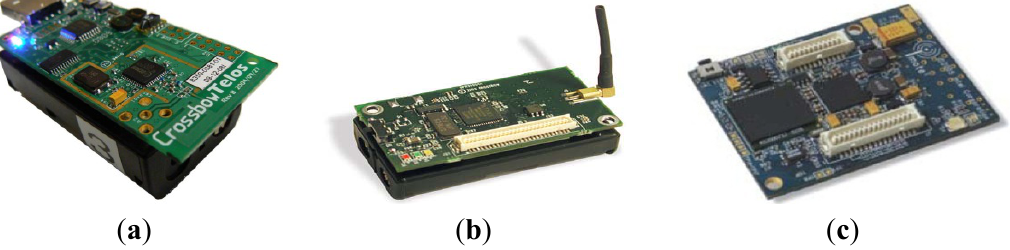
Figure 1. Sensor Networking Platforms. ( a ) Telos; ( b ) MicaZ; ( c )